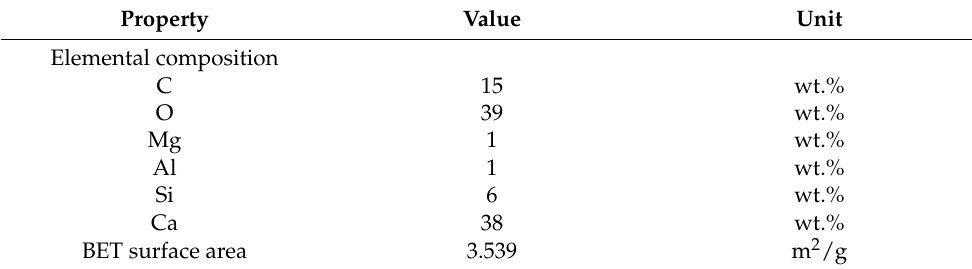
Figure 1. SEM image of catalyst at 2000 × magnification. Table 1. Catalyst